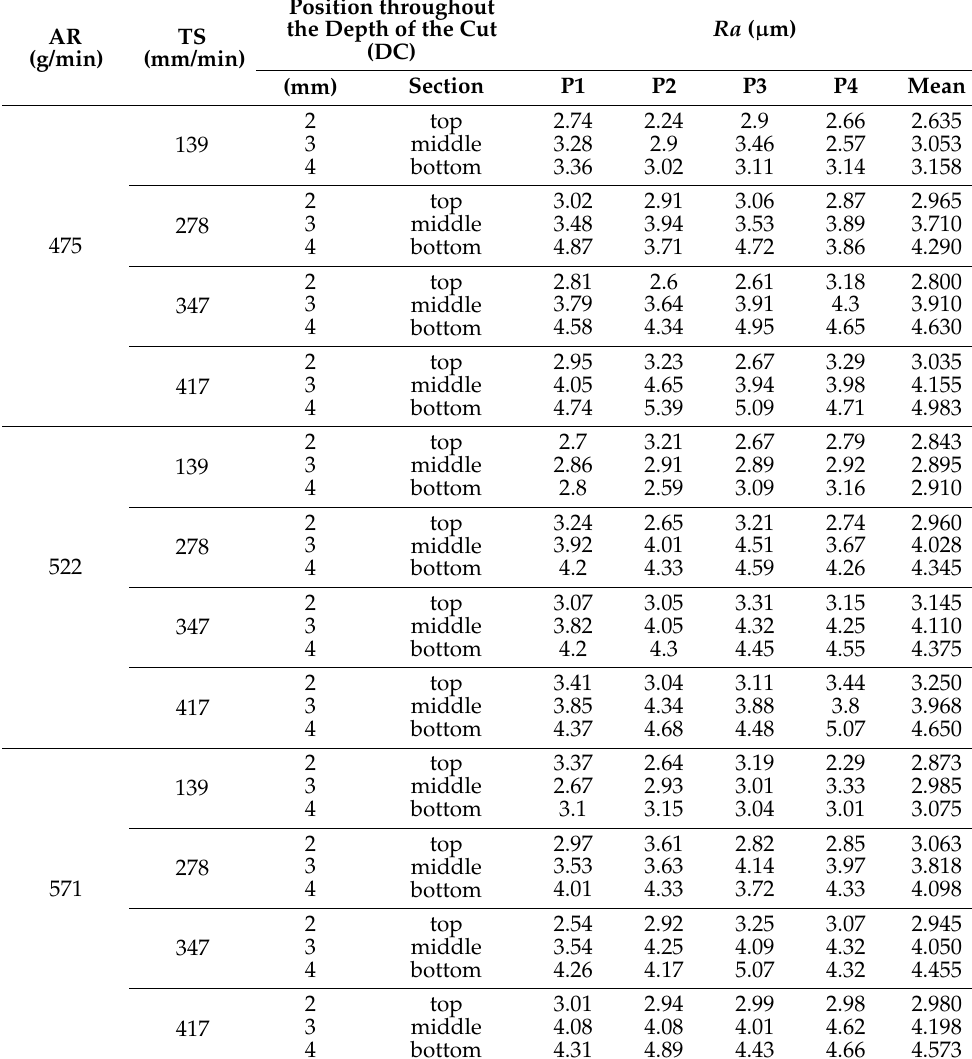
Table 3. Ra values in the machining of the workpiece with 5 mm